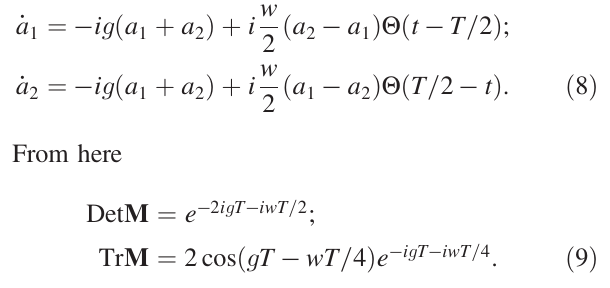
FIG. 5. Same for the vertical case. Note that stability at zero chromaticity is reestablished at w ≥ 22 (mode decoupling).